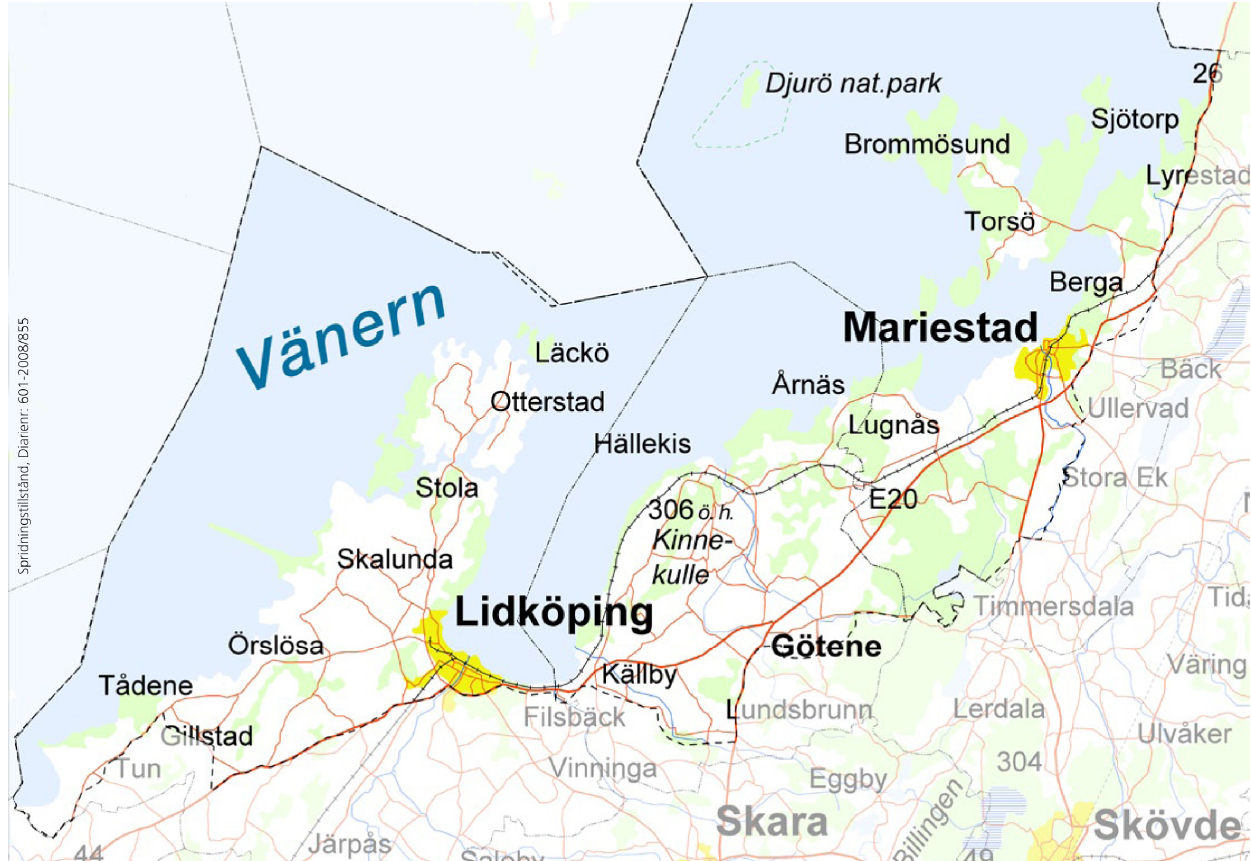
Figure 1. Lake Vänern Archipelago Biosphere Reserve in Sweden includes the three municipalities, Mariestad, Götene and Lidköping. Source: Lantmäteriet state of dispersal Dnr 601-2008-855